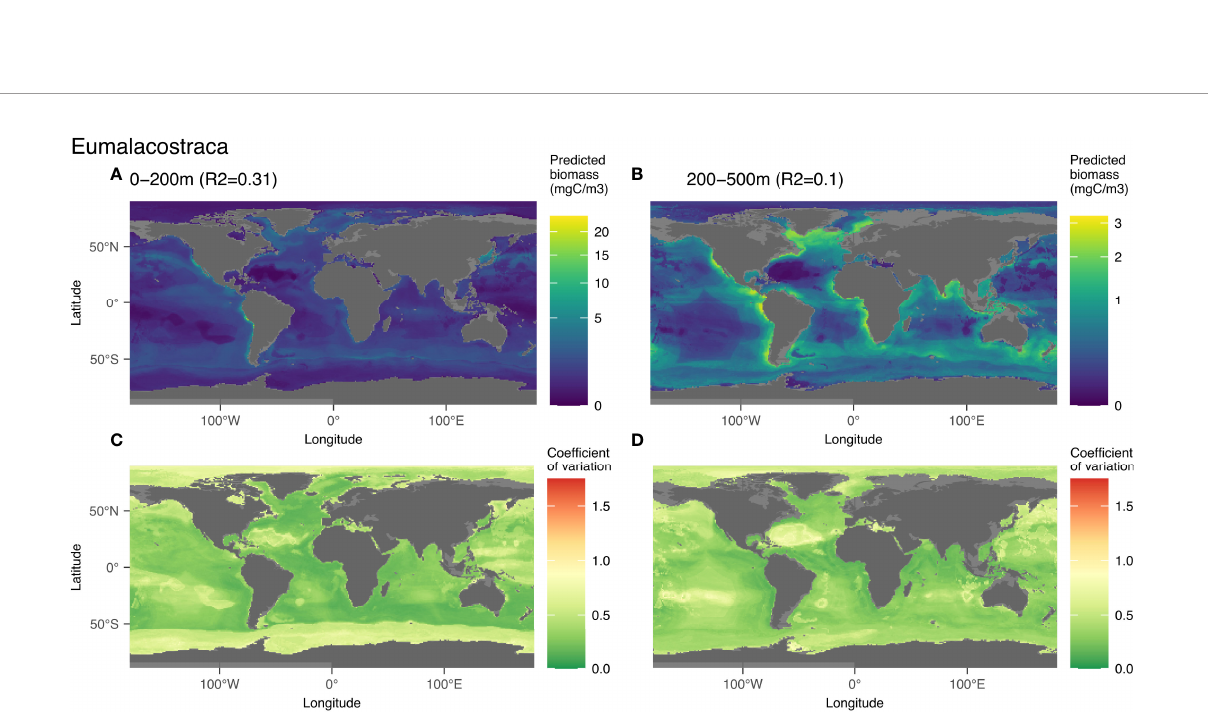
FIGURE 6 | Map of the mean biomass (color scale is log-transformed) of Copepoda as predicted by the model on 0-200 m (A) 200-500 m data (B) as well as the coef fi cient of variation for the 0-200 m model (C) and 200-500 m one (D) . The color scale for the coef fi cient of variation has the same range for Figures 5 – 9 .